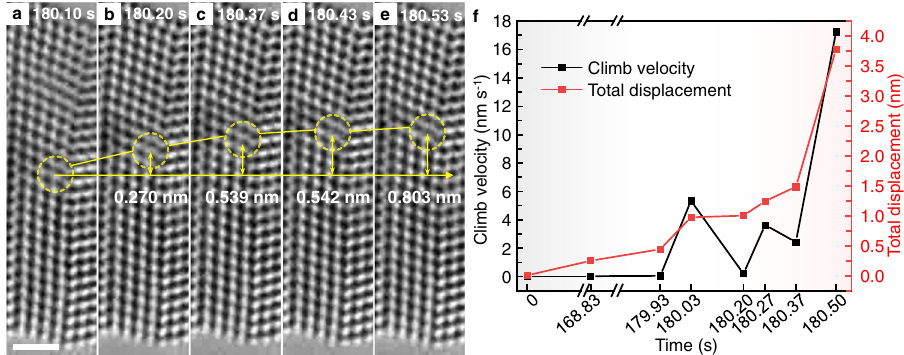
Fig. 2 Climb velocity and displacement of dislocation “ 4 ” measured from the HRTEM images. a - e HRTEM images showing fast movement of the core (circled by dashed lines). Scale bar: 1 nm. f Climb velocity and displacement of dislocation “ 4 ” as a function of time during the whole in situ straining